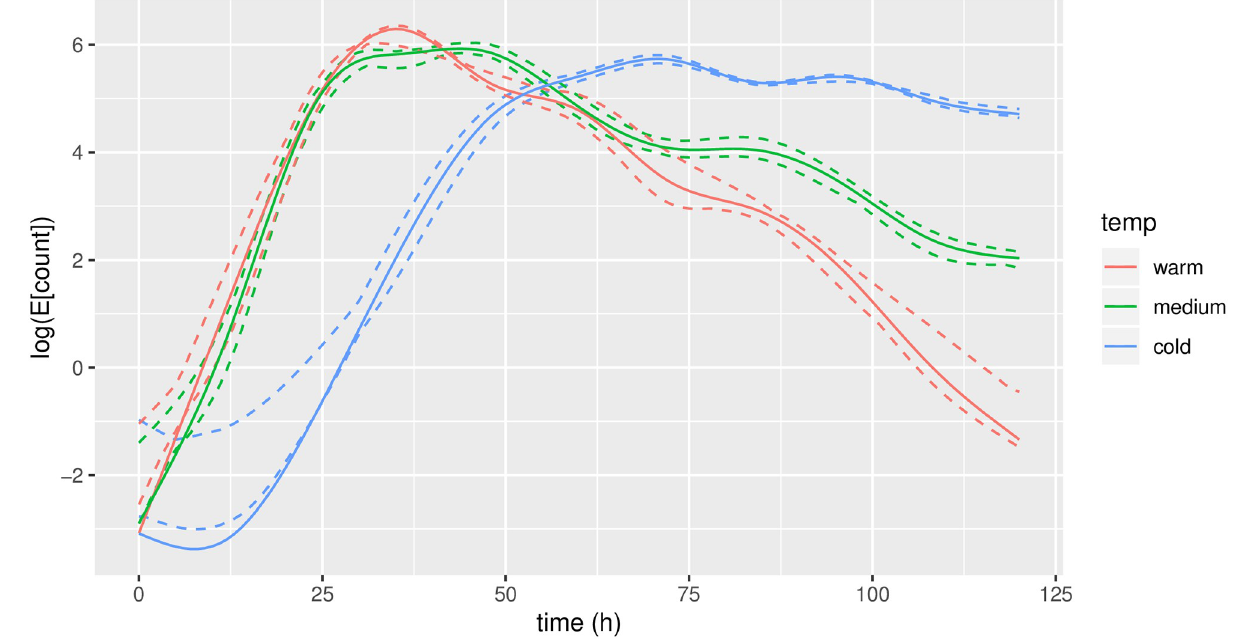
Fig 8. Pointwise estimates, and upper and lower bounds for leave-one-out